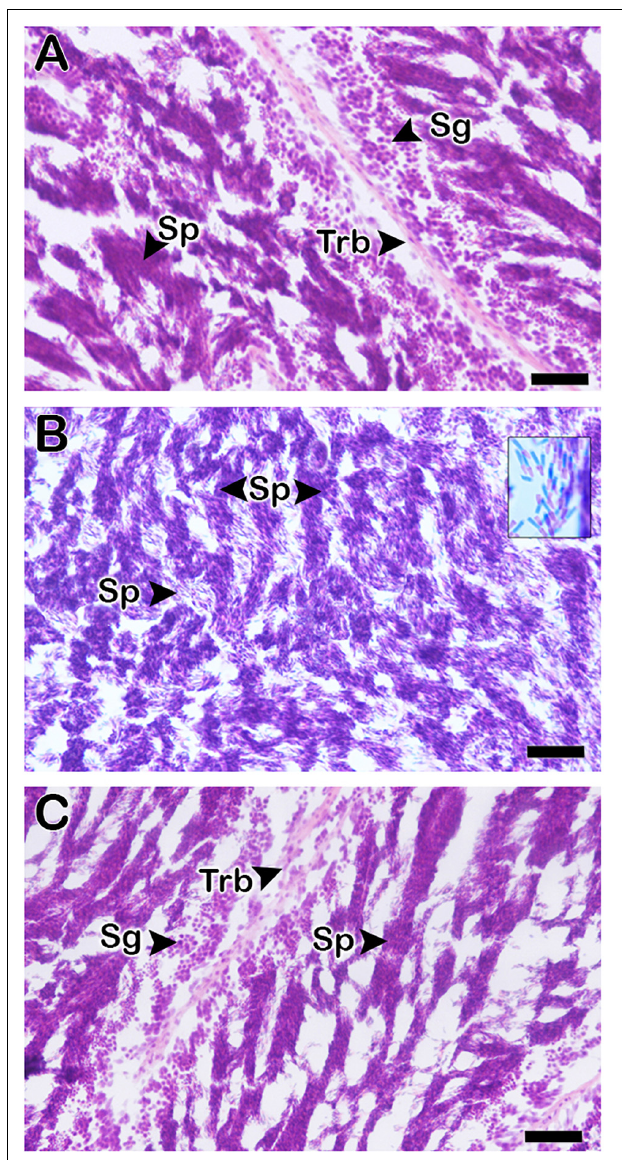
FIGURE 2 | Histological analysis of testes in Pacific abalone ( H. discus hannai ) on day-7 in the second experiment during the peak breeding season after exposure to three temperature treatments ( A: 16 ◦ C; B: 21 ◦ C; and C: 26 ◦ C) by hematoxylin–eosin staining. Low (A) and high (C) water temperature group of abalone showed distinct differences in mature sperm content compared to normal water temperature (B) group of abalone. The inset picture in (B) is at higher magnification of sperm. Sg, spermatogonia; Sp, sperm; Trb, trabeculae. Scale bar: 100 µ